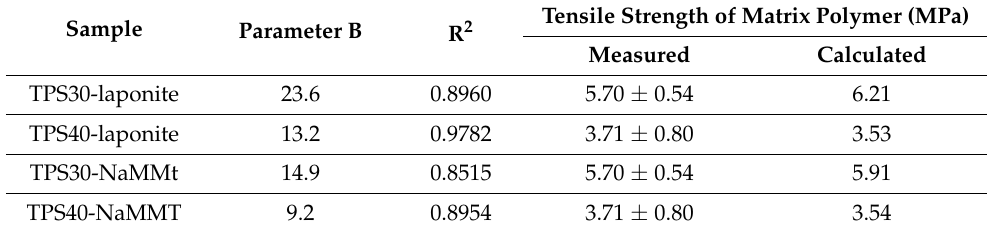
Figure 8. Reduced tensile strength of TPS nanocomposites plotted against filler content; ( a ) TPS/laponite, ( b ) TPS/montmorillonite. Table 4. Effect of matrix polymer and clay type on reinforcement.